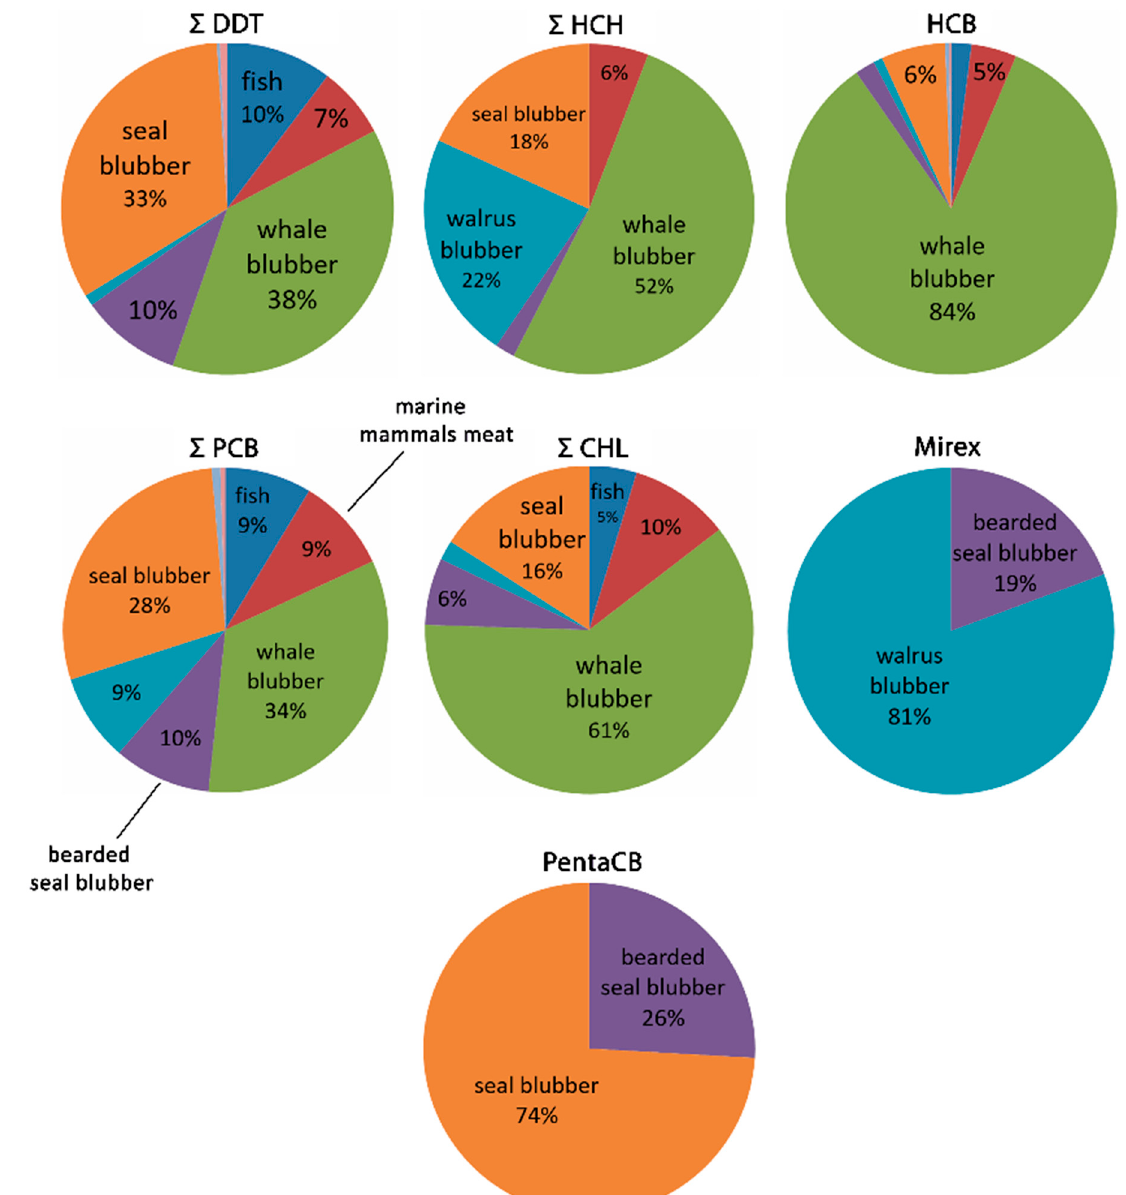
Figure 3. Structure of the Estimated Daily Intakes (EDIs) of POPs by local food consumption, %.